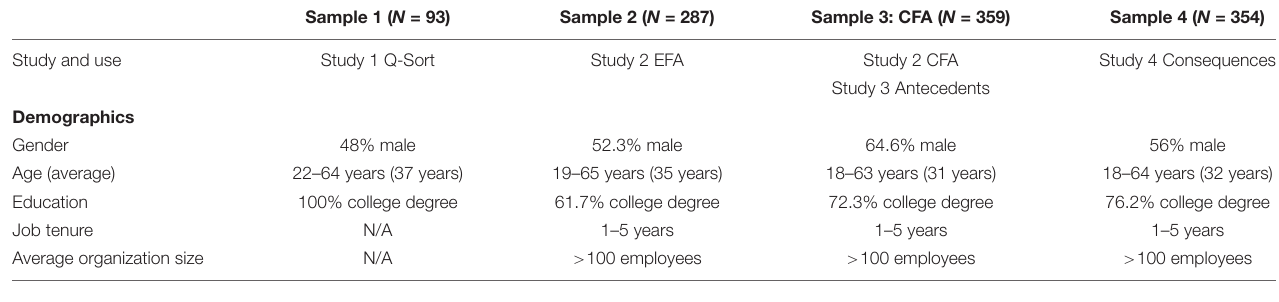
TABLE 4 | Item correlations for retained items*.